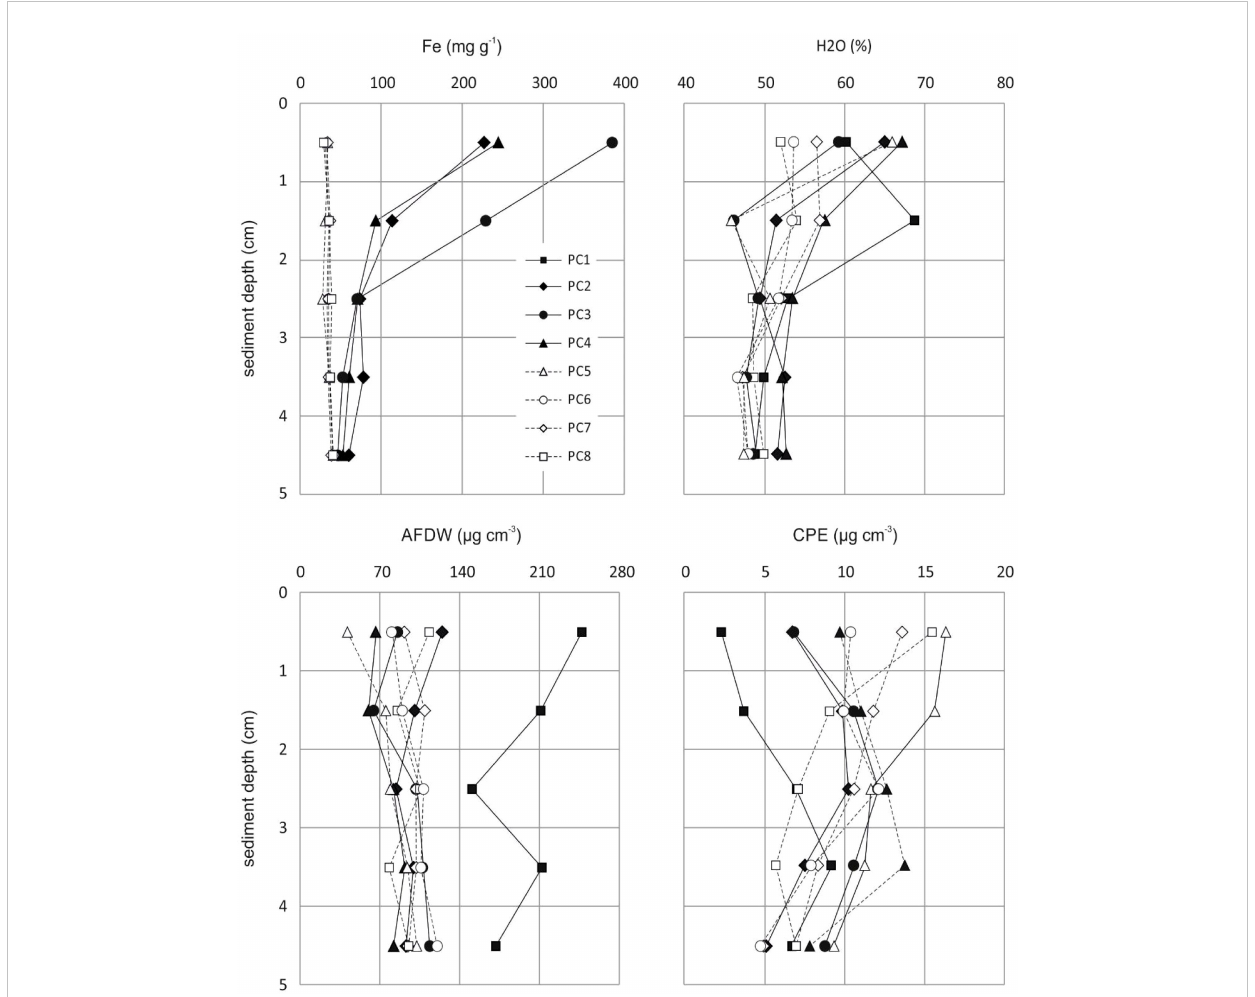
FIGURE 3 Gradients in iron concentrations (Fe; top left), water contents (H2O; top right) and organic matter contents (AFDW: bottom left; CPE: bottom right) in surface sediments along the transect with increasing distance from the corroding bottom-weights (no data for iron concentrations at